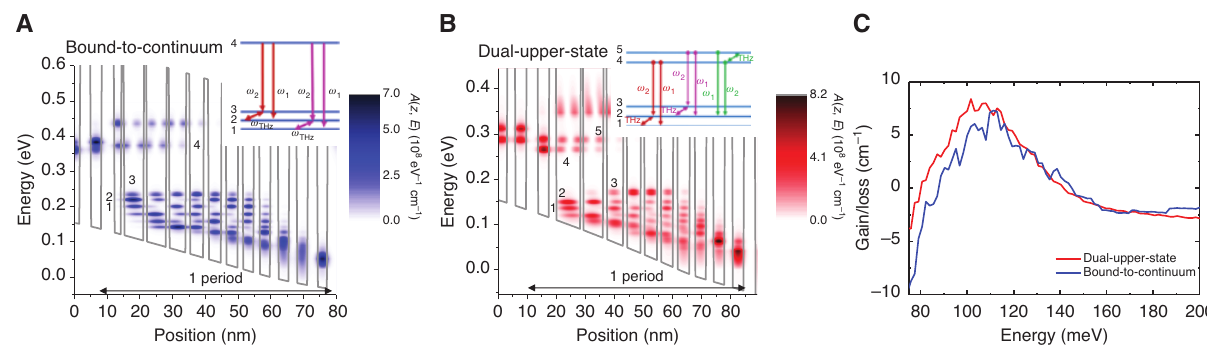
Figure 3: Active region structures for THz DFG-QCLs. (A) Contour plot of the spectral function A ( z , E ) of a λ ≈ 9.3 μ m BTC active region design for THz DFG-QCLs as a function of position z and energy E . State 4 is the upper laser state, while states 3, 2, and 1 represent the lower laser state manifold. Relevant triplets of states that produce strong nonlinearity for THz DFG are shown in the inset. (B) Contour plot of the spectral function A ( z , E ) of a DAU active region design for THz DFG-QCLs as a function of position z and energy E . States 5 and 4 are the upper lasing states, while states 3, 2, and 1 represent the lower lasing state manifold. Relevant triplets of states that produce strong nonlinearity for THz DFG are shown in the inset. (C) Absorption/ gain amplitude of the BTC and DAU active region designs, calculated with the NEGF transport